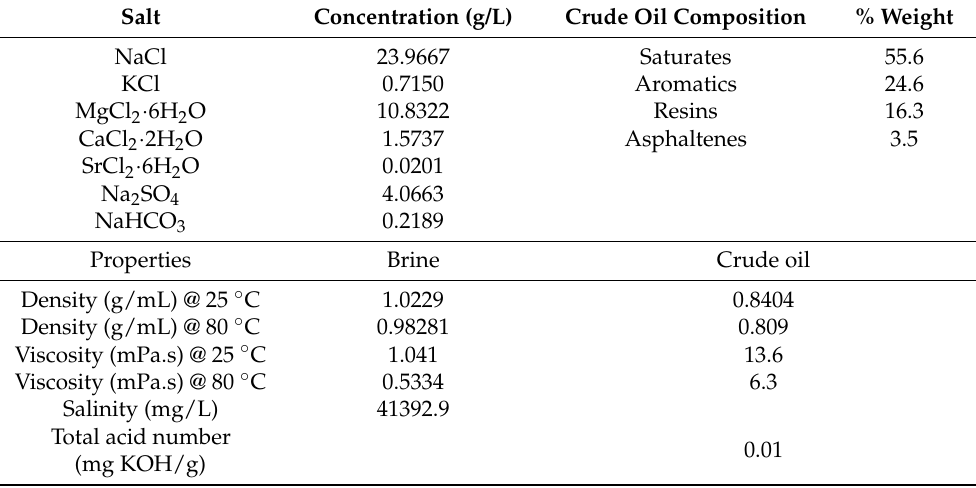
Table 2. Brine and crude oil compositions and